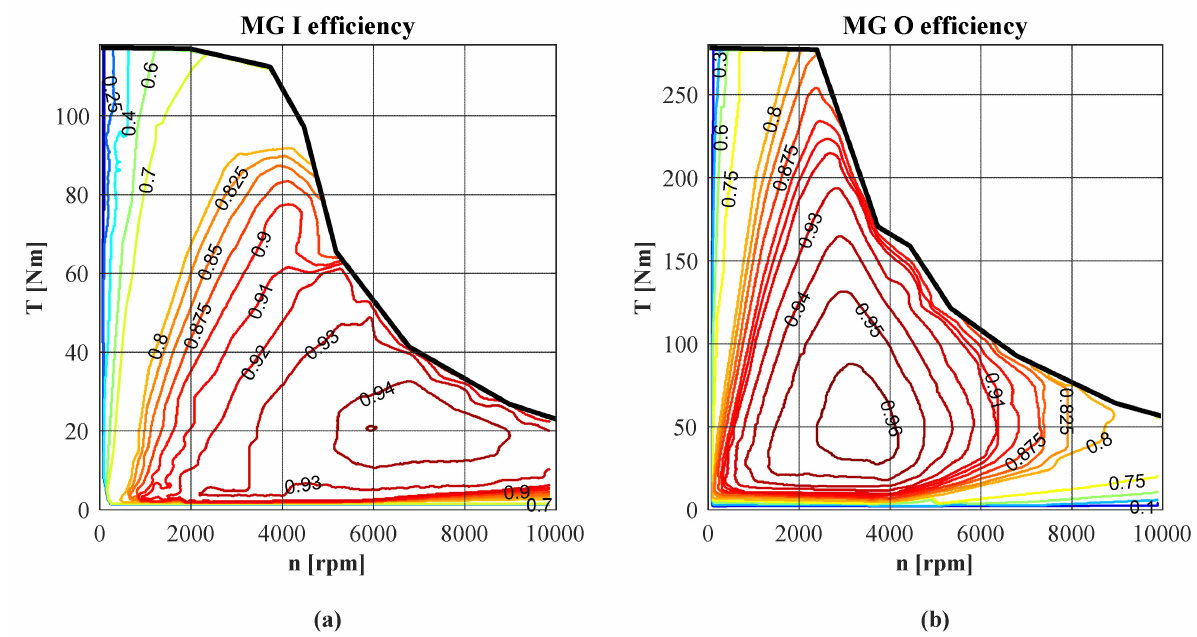
Figure 5. Efficiency maps of Chevrolet Volt electric machines derived from [38]; ( a ) Motor Generator I; ( b ) Motor Generator O. Exploited for both motoring and generating